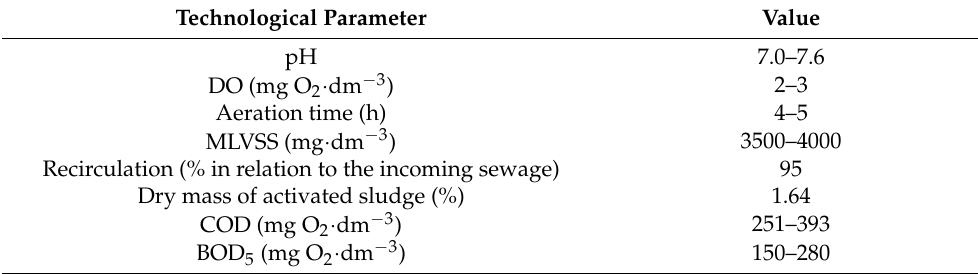
Table 1. Basic technological parameters of wastewater and activated sludge used in the research. Technological